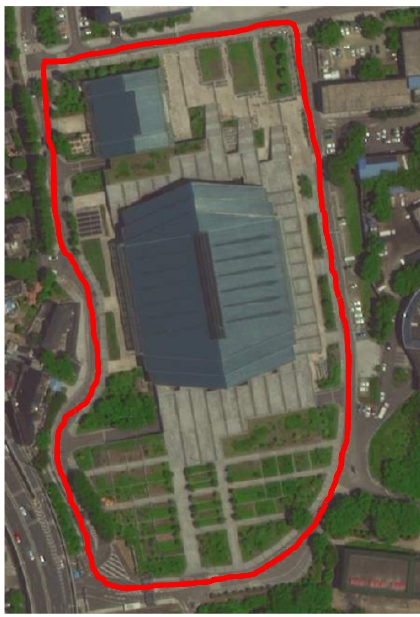
Figure 5. satellite image of Wuhan University Zall Stadium